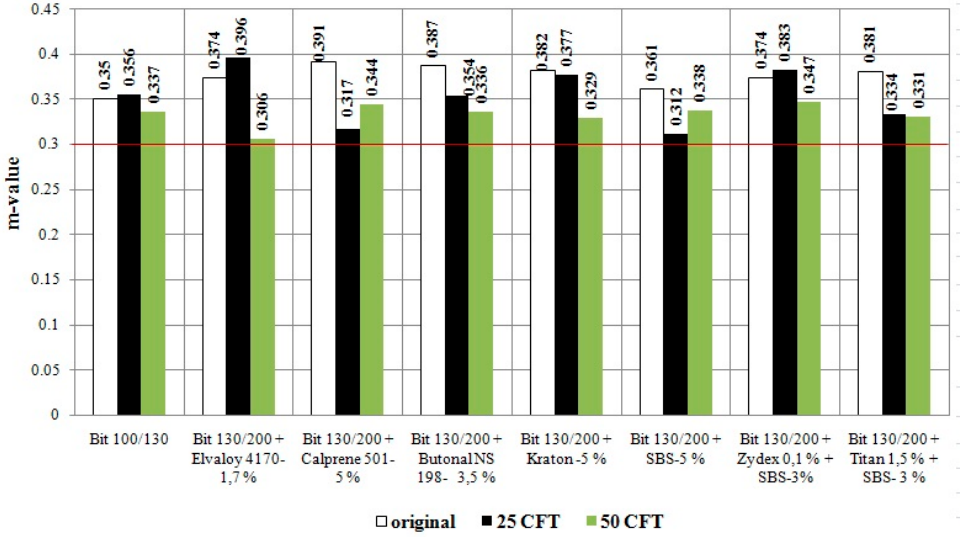
Figure 10. Bitumens m-value at the temperature of − 24° С .